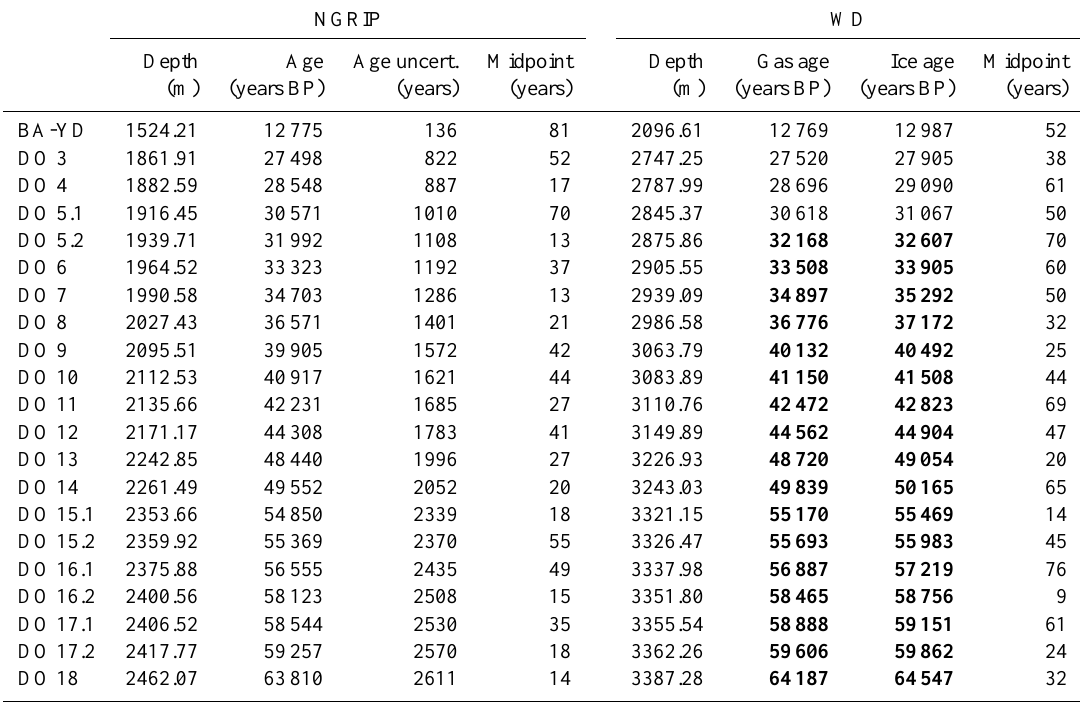
Table 2. Overview of CH 4 tie points for NH cooling events. WD ages printed in boldface are assigned as part of the CH 4 synchronization; all other ages are on their independent